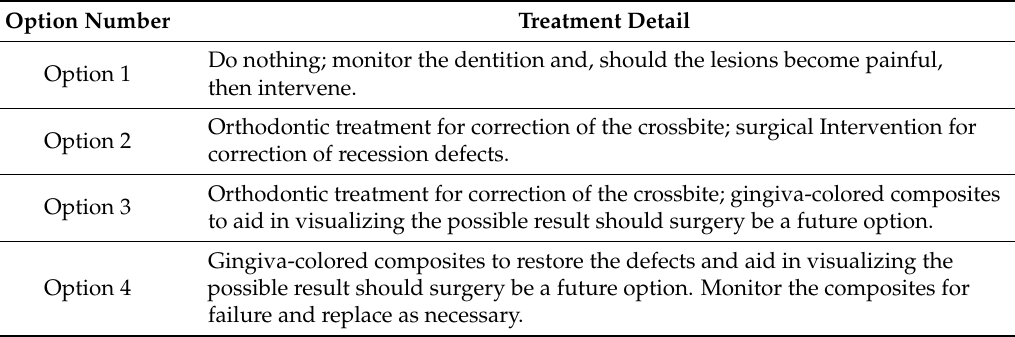
Figure 1. Preoperative anterior view. Table 1. Treatment options.